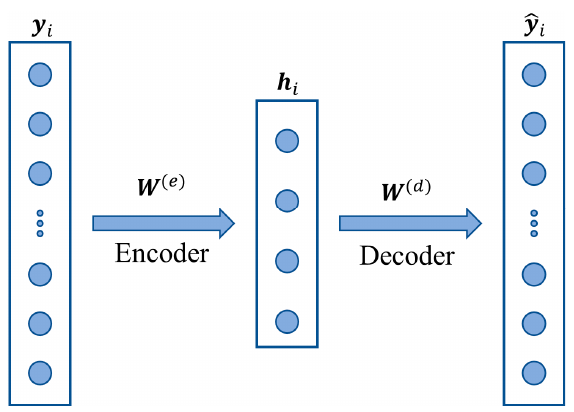
Figure 1. Work fl ow of the conventional AE unmixing network. Figure 1. Workflow of the conventional AE unmixing